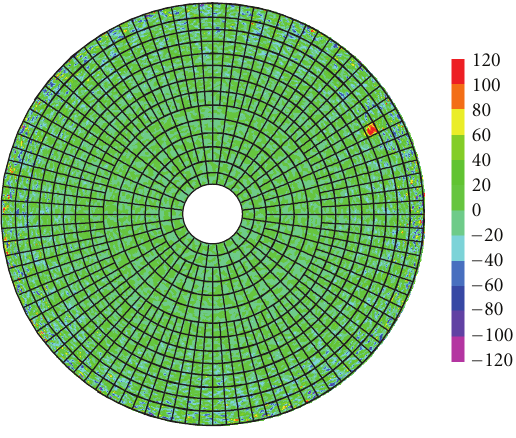
Figure 11: Map of the retrieved reflector surface for a deformation of 100 μ m of the panel under test. SNR = 48 dB. The color bar is in unit of μ m.